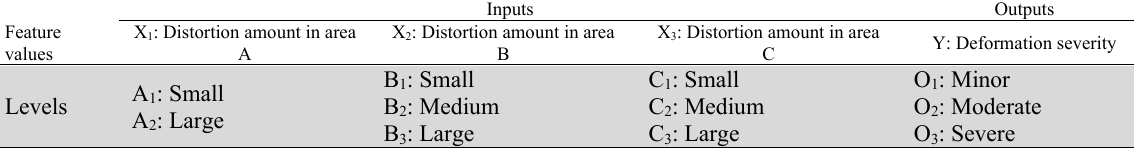
The inputs and outputs of the proposed fuzzy inference system